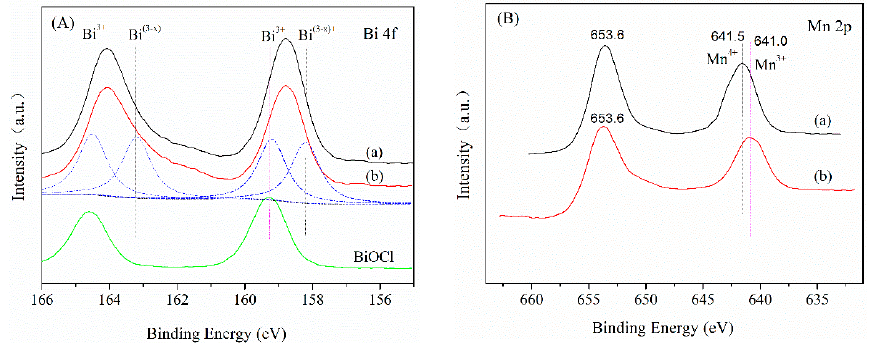
Figure 7. XPS spectra of ( A ) Bi 4f and ( B ) Mn 2p , (a) 0.01BiOCl/MnMgAl − HT and (b) 0.01BiOCl/MnMgAlO .